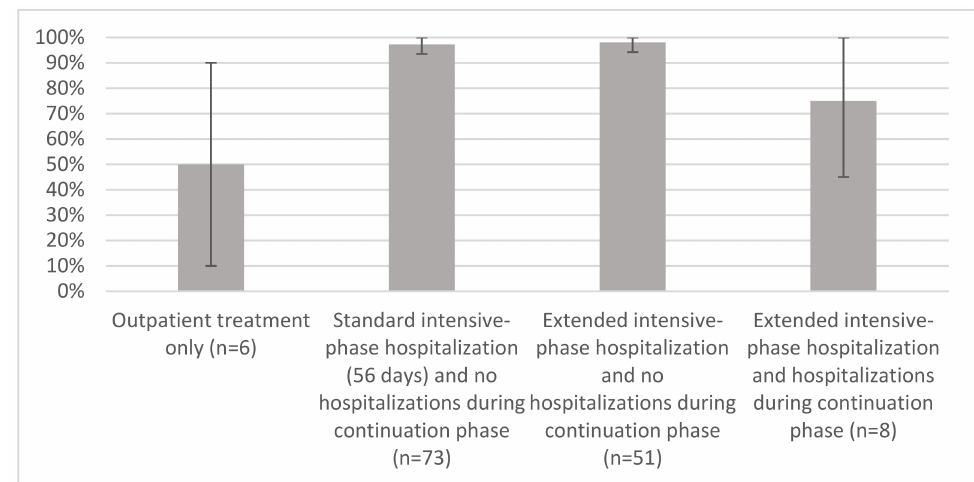
Figure 1. Proportions of drug-susceptible patients who were cured or completed UGTB treatment by different hospitalization patterns, Tashkent, Uzbekistan, 2016–2018, % and 95% confidence